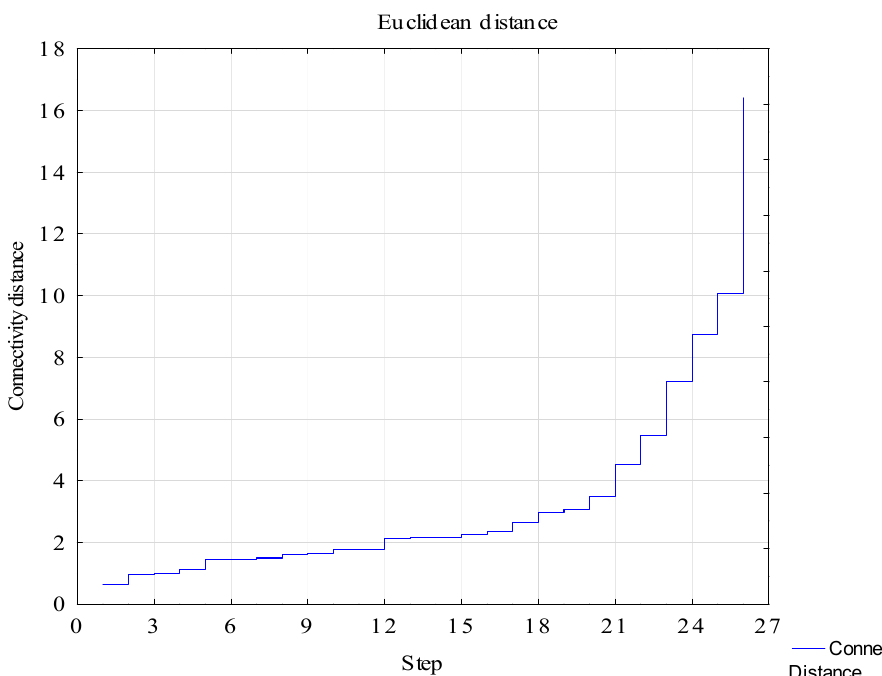
Figure 4. Diagram of the course of agglomeration for 2020. Source: author’s own study.